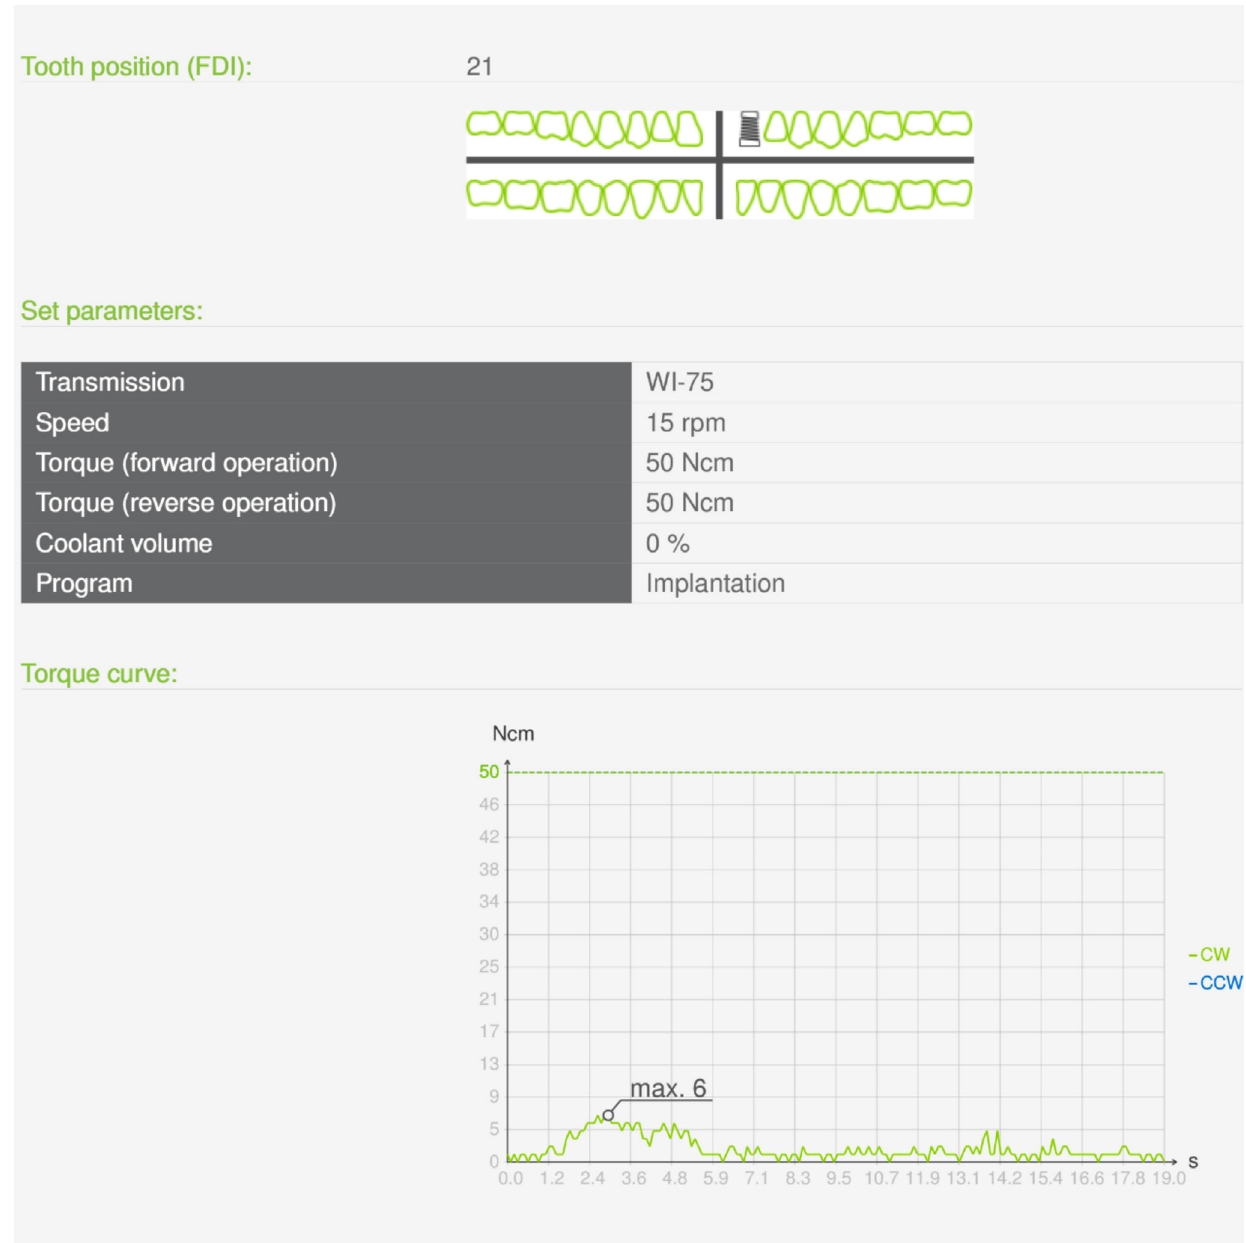
Fig. 2. Final insertion torque dropped to